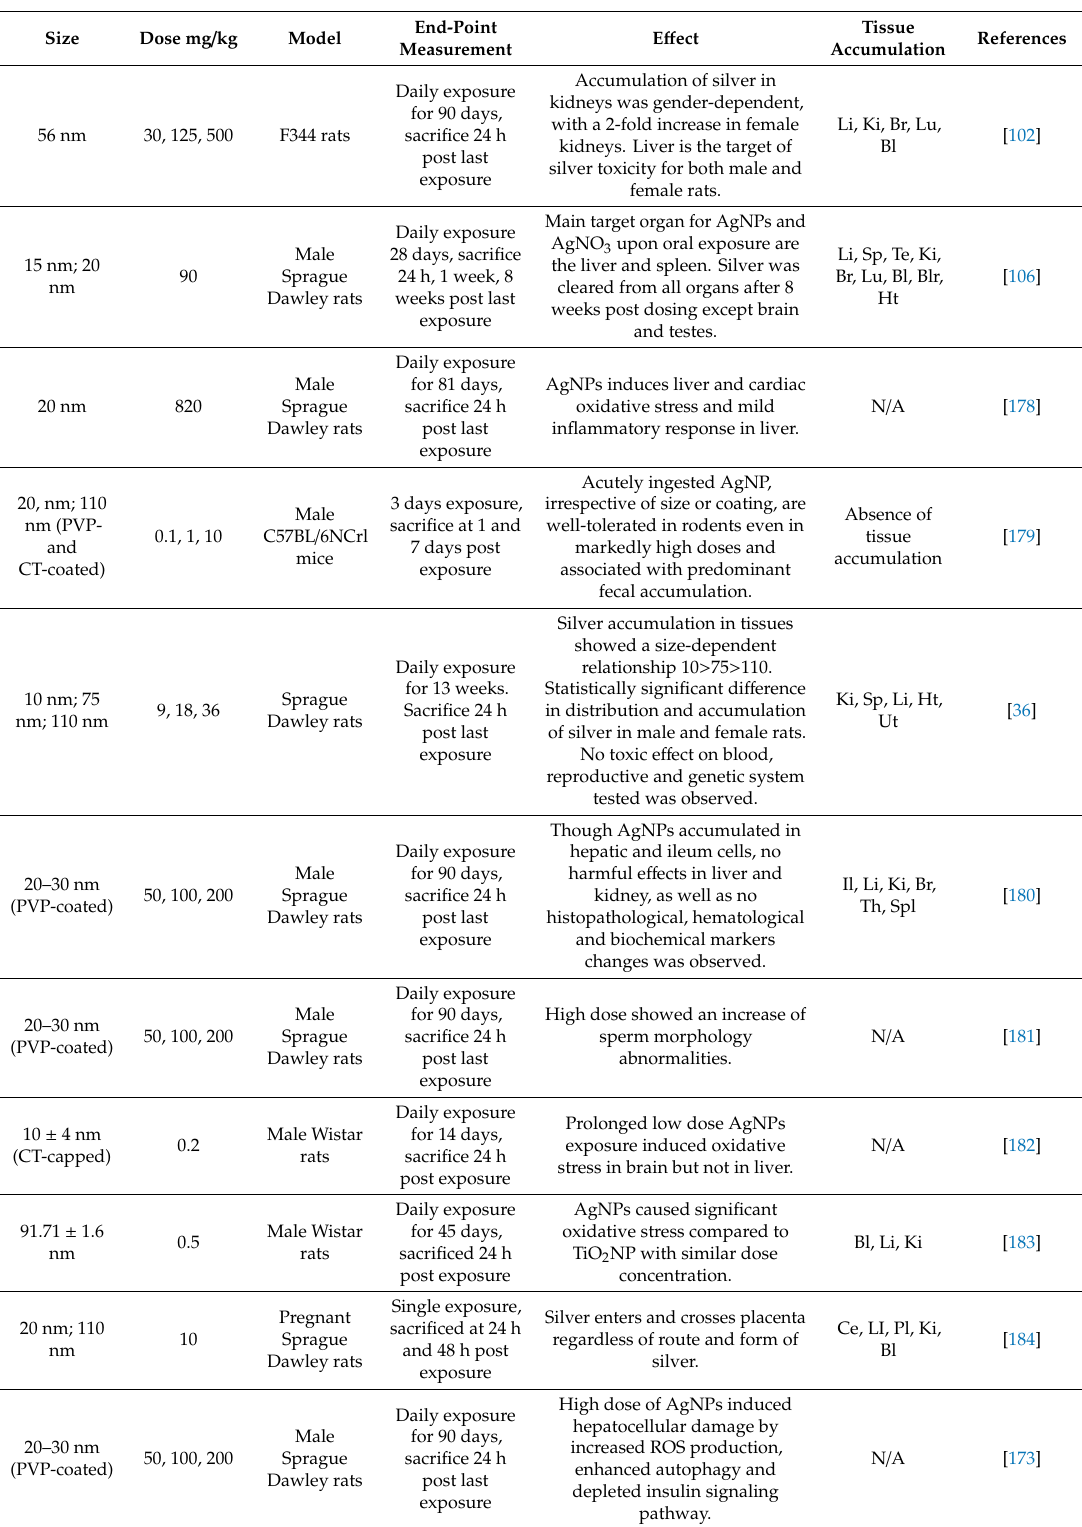
Table 3. Toxicity and biodistribution of AgNPs in rodents via oral